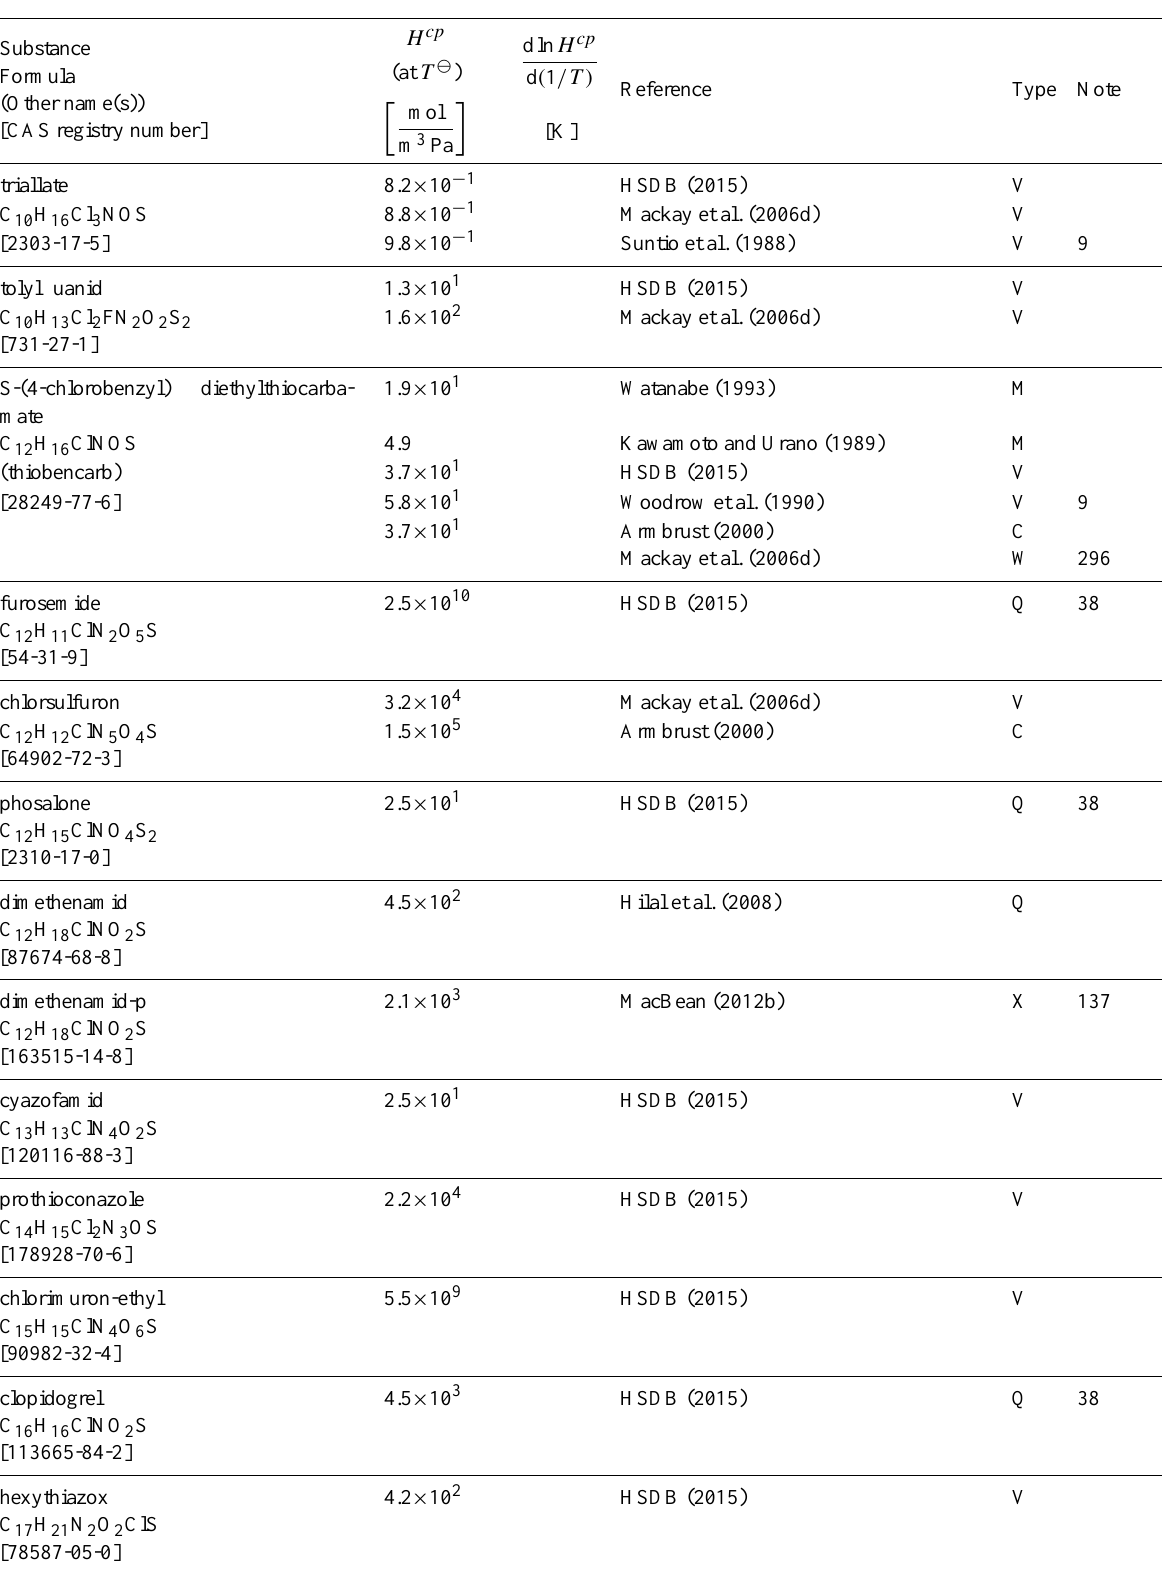
Table 6: Henry’s law constants for water as solvent